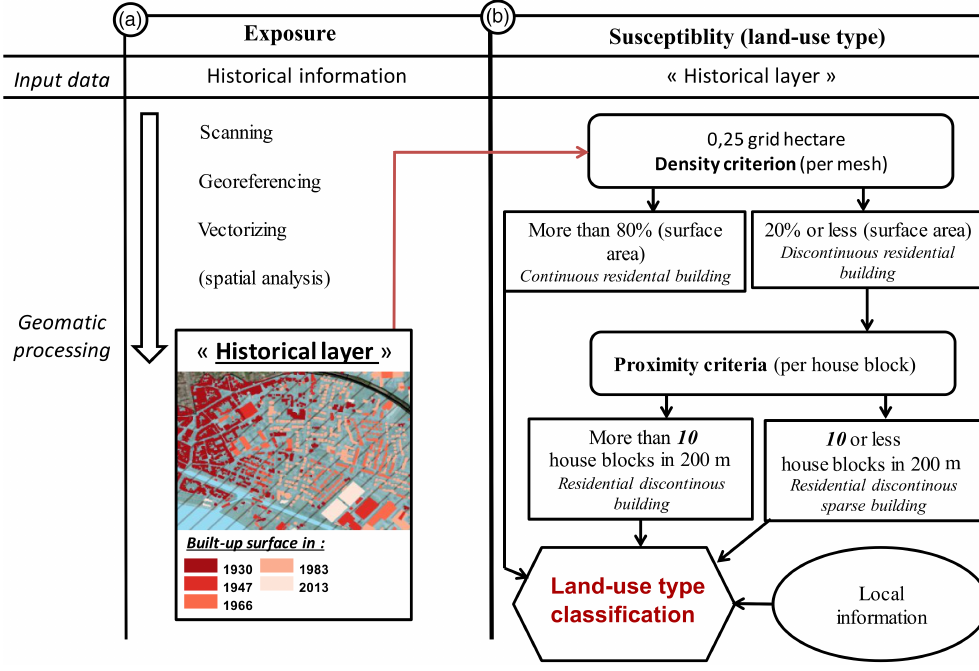
Figure 6. Evolution of vulnerability: (a) exposure and (b) susceptibility (building use